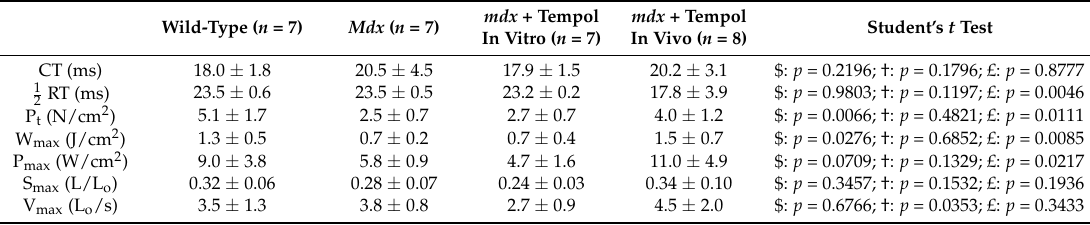
Figure 1. Peak Isometric Tetanic Force. Representative traces for muscle twitch ( A ) and tetanic ( B ) contractions and maximum unloaded shortening ( C ) for diaphragm muscle from wild-type, mdx , mdx + tempol in vitro and mdx + tempol in vivo. Group data for diaphragm muscle peak tetanic force ( D ) from wild-type ( n = 7), mdx ( n = 7), mdx + tempol in vitro ( n = 7) and mdx + tempol in vivo ( n = 8). For the mdx + tempol in vitro group, diaphragm muscle preparations were studied in Krebs solution containing 1 mM tempol in vitro. The mdx + tempol in vivo group received 1 mM tempol in their drinking water for two weeks. Values are expressed as box and whisker plots (median, 25–75% centiles and minimum and maximum values) and data were statistically compared by Student’s t tests. *** p < 0.0001; ** p = 0.0069. Table 1. Diaphragm Muscle Contractile Properties.